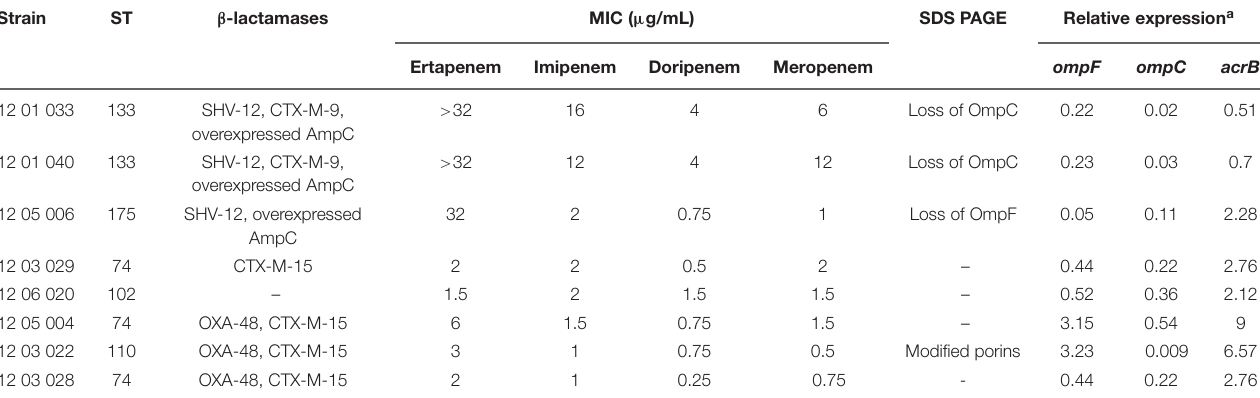
TABLE 2 | Contribution of efflux and reduced outer membrane permeability to carbapenems for E. cloacae strains resistant to ertapenem. Strain